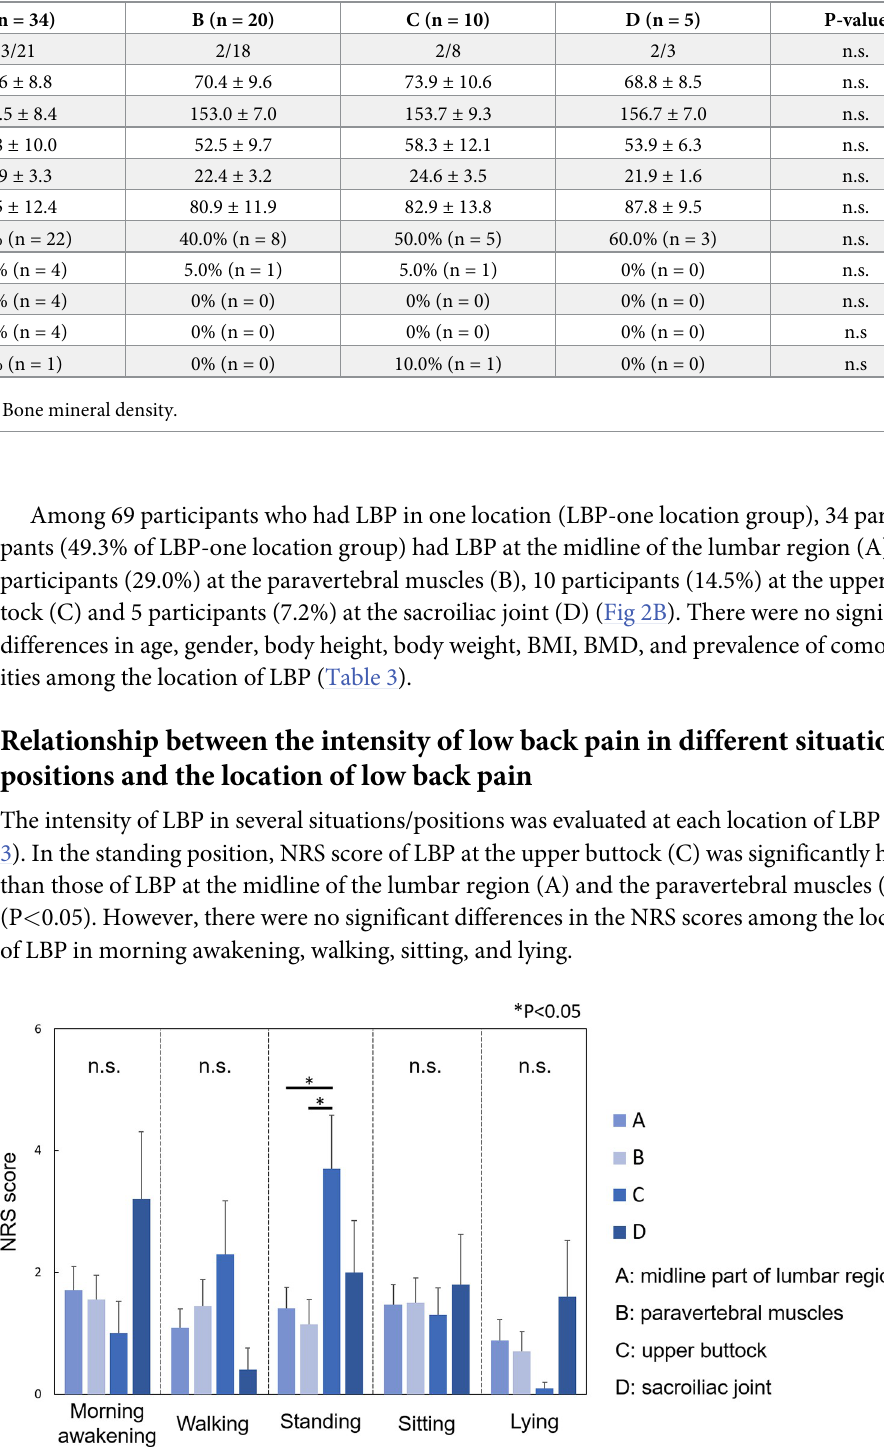
Fig 3. Relationship between the intensity of low back pain and the location of low back pain. NRS scores of the LBP-one location group in several situations/positions were assessed by the location of LBP. 1. Morning awakening, 2. Walking, 3. Standing, 4. Sitting, and 5. Lying down. A. midline of the lumbar region, B. paravertebral muscles, C. upper buttock, and D. sacroiliac joint. NRS: Numerical rating scale; LBP: Low back